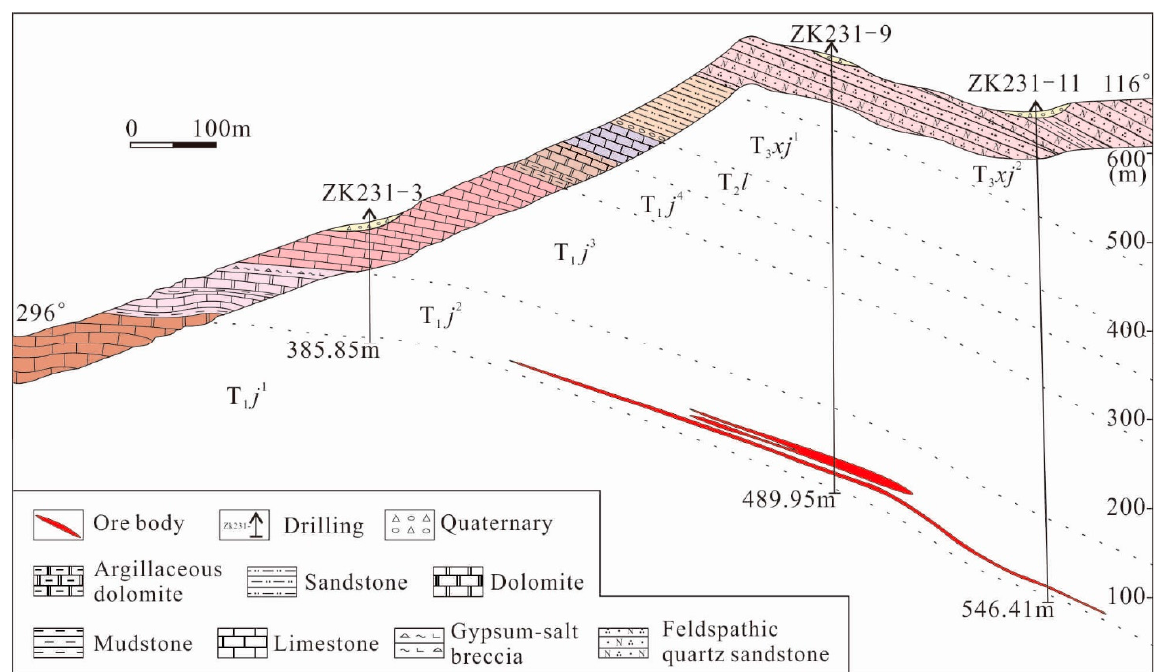
Figure 2. Geological map of the deposits in the Xishan anticline, showing the sampling location.